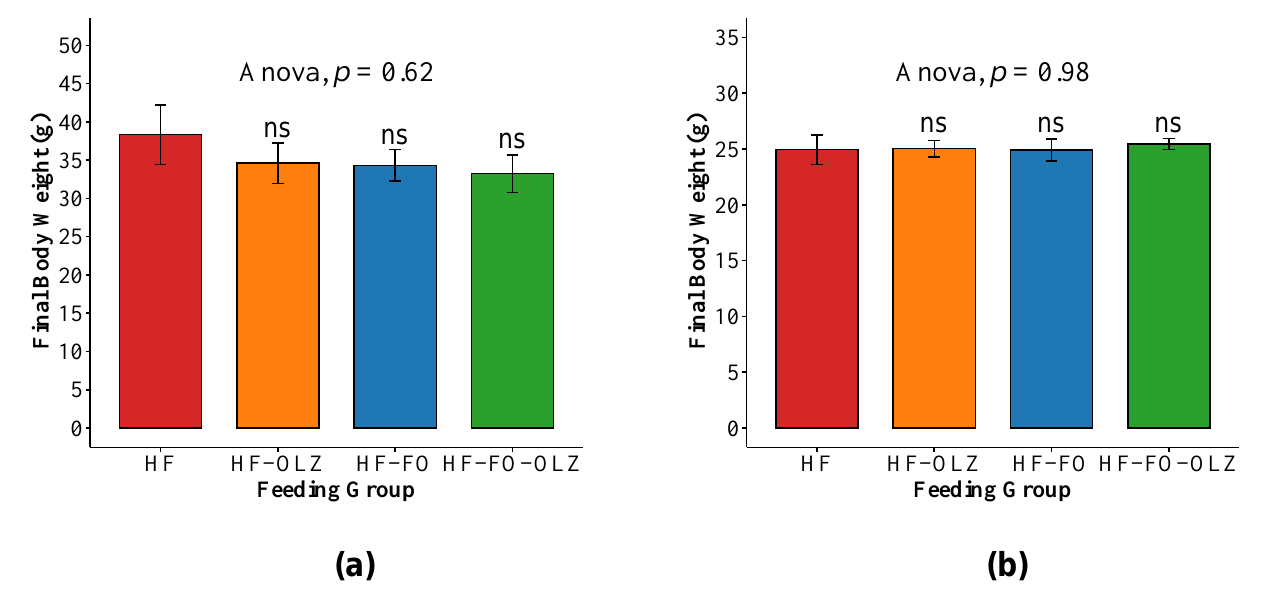
Figure 1. Final body weight in male ( a ) and female ( b ) mice. Data are shown as mean ± SEM for each group. ANOVA p -value for the multiple group comparisons are shown. The pairwise comparison is to compare the HF group versus the other groups, individually (ns for p -value ≥ 0.05). 3.2. Fish Oil Significantly Reduced Lipopolysaccharide Binding Protein (LBP) Levels in Male Mice Serum levels of LBP in the HF group was compared to HF-OLZ, HF-FO, and HF-FO- OLZ, individually for both male and female mice. LBP levels were comparable between the HF-OLZ and HF groups, while the HF-FO and HF-FO-OLZ groups had significantly lower LBP levels compared to the HF group in male mice (Figure 2a). In female mice, there was no statistically significant difference in LBP levels across groups (Figure 2b).